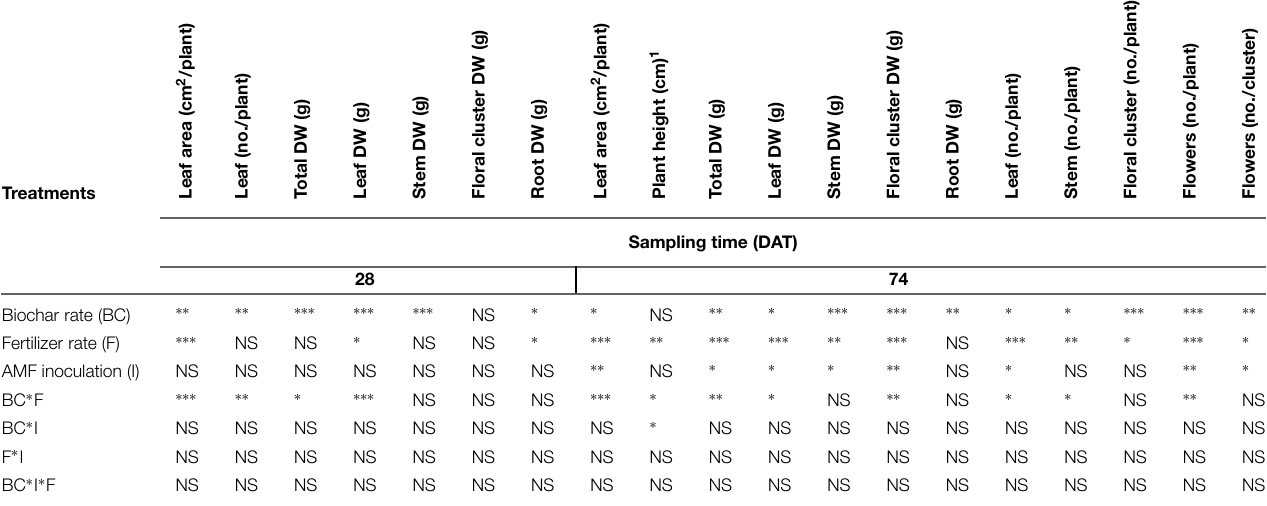
TABLE 4 | Significance of F test for media, AMF inoculation, and fertilization rate treatments on container-grown Pelargonium vegetative structure and flowering traits after 28 and 74 DAT.